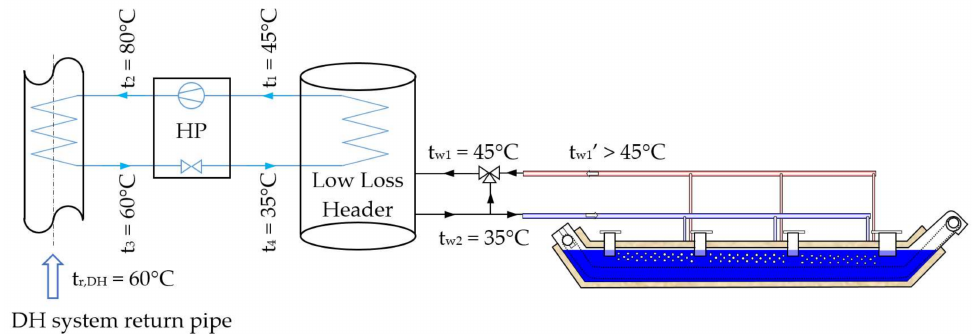
Figure 13. Detailed schematic diagram of the proposed slag heat recovery system based on a high temperature heat pump